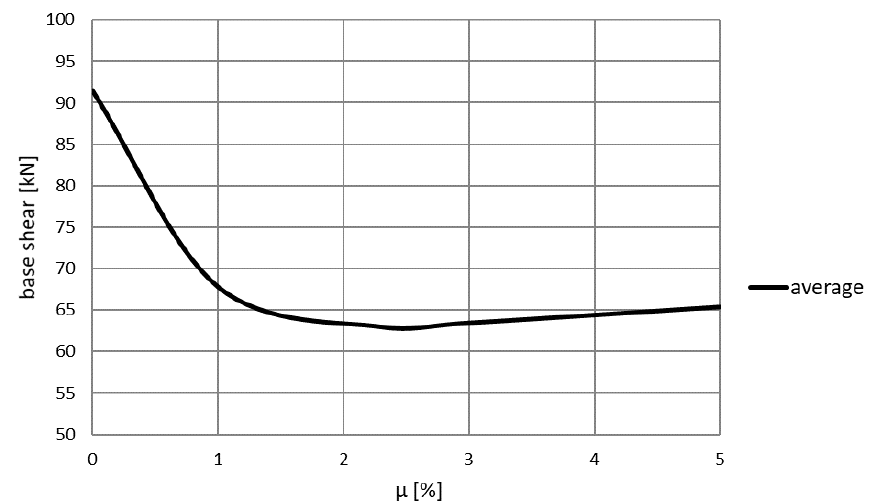
Figure 11. Base shear against the mass ratio, μ considering the TMD positioned at 40.00 m.